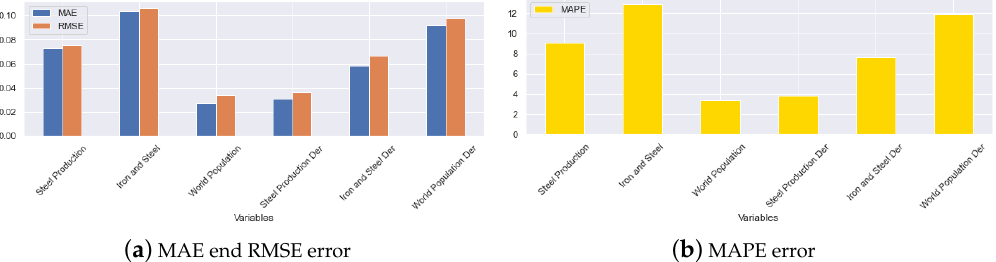
Figure 14. The test error one, used the same architecture with GRU unit.